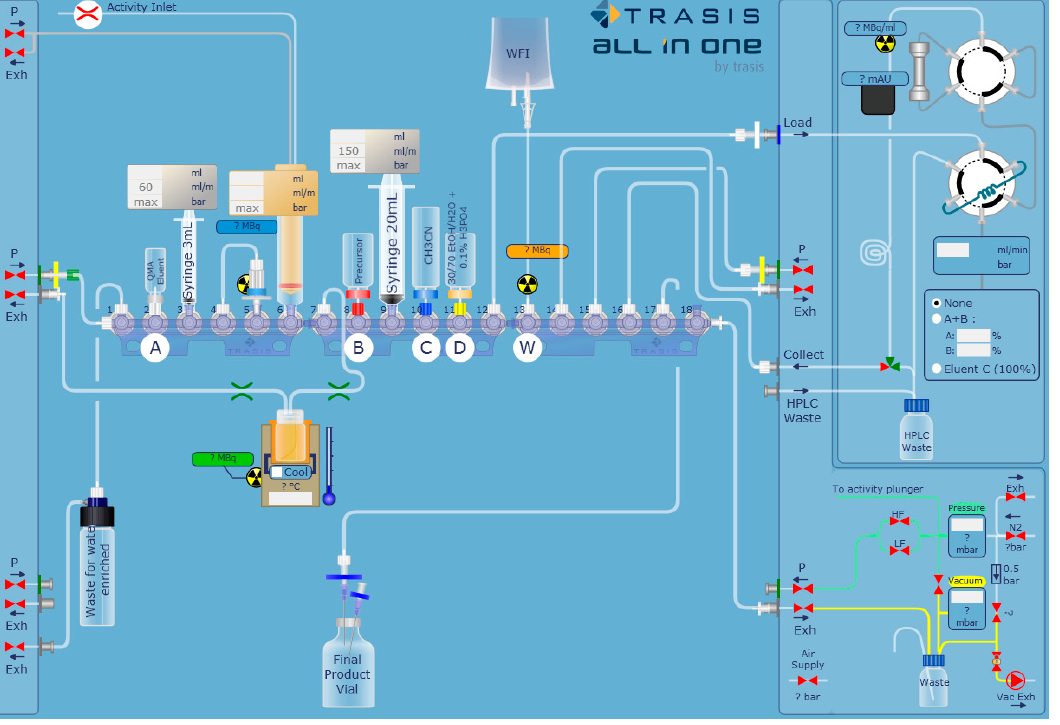
Table 2. List of reagents.